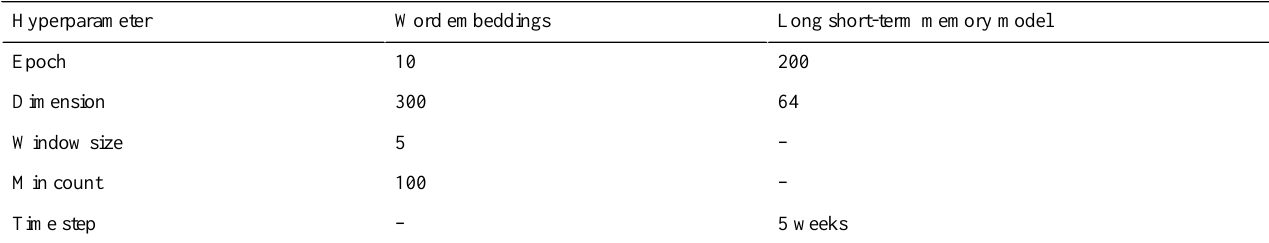
Long short-term memory modelWord